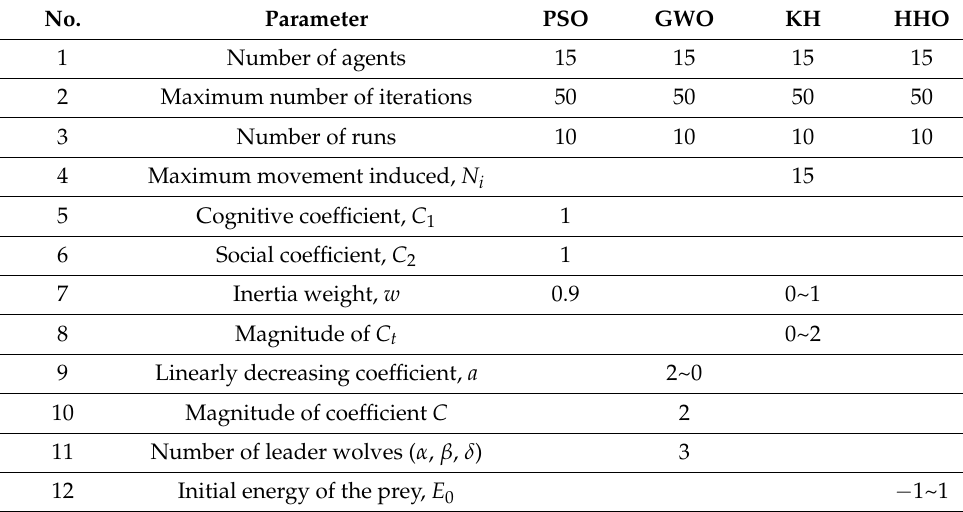
Figure 20. One-day equivalent power output of the wind turbine. Table 1. Parameters of four swarm intelligence-based optimization algorithms.